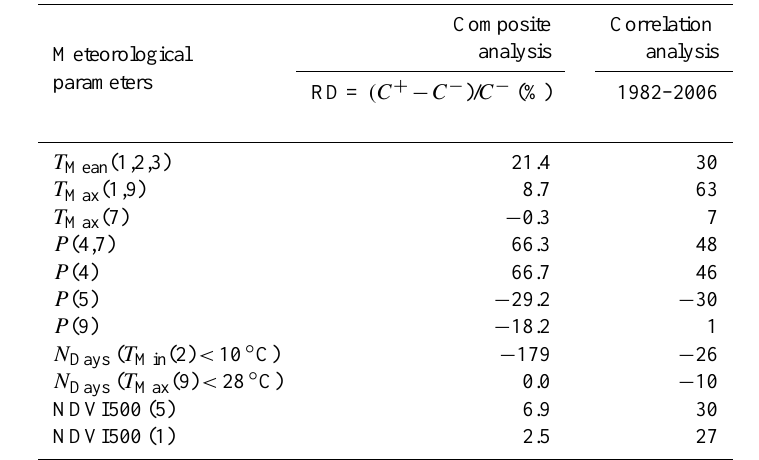
Table 1. Values of: (i) the relative difference between composites obtained for positive and negative years; and, (ii) the Spearman correlation coefficients between selected meteorological parameters and corrected chestnut productivity. T Mean , T Max and T Min are the average of the mean, maximum and minimum air temperature; P is the accumulated precipitation, N Days accounts for the number of days that meets the condition in brackets and NDVI500 represents the NDVI for the pixels with the chestnut trees as the main occupant located above 500m. All variables/parameters were computed for a specific month or group of months indicated in parenthesis.